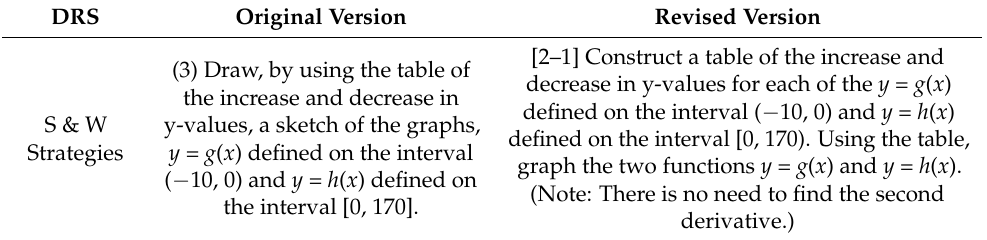
Table 6. S and W Strategies.